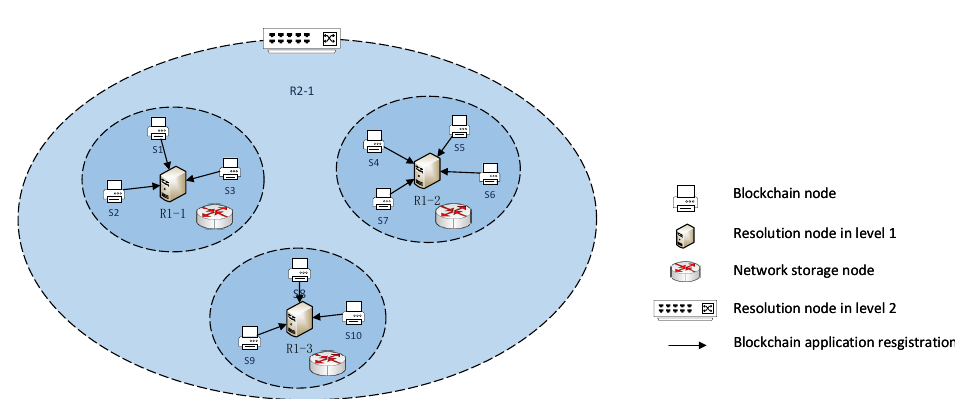
Figure 4. Blockchain application registration.